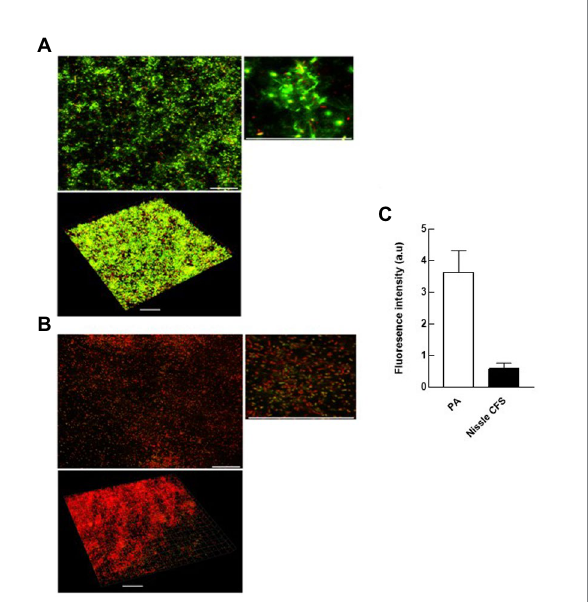
FIGURE 5 E. coli Nissle cell-free supernatant (CFS) reduces eDNA in extant biofilms. 2D and 3D confocal images of P. aeruginosa (PA) biofilms grown in the absence (A) and presence (B) of cell-free supernatants of E. coli Nissle. (C) Quantification of fluorescence signals derived from CLSM 3D imaging. See legend to Figure